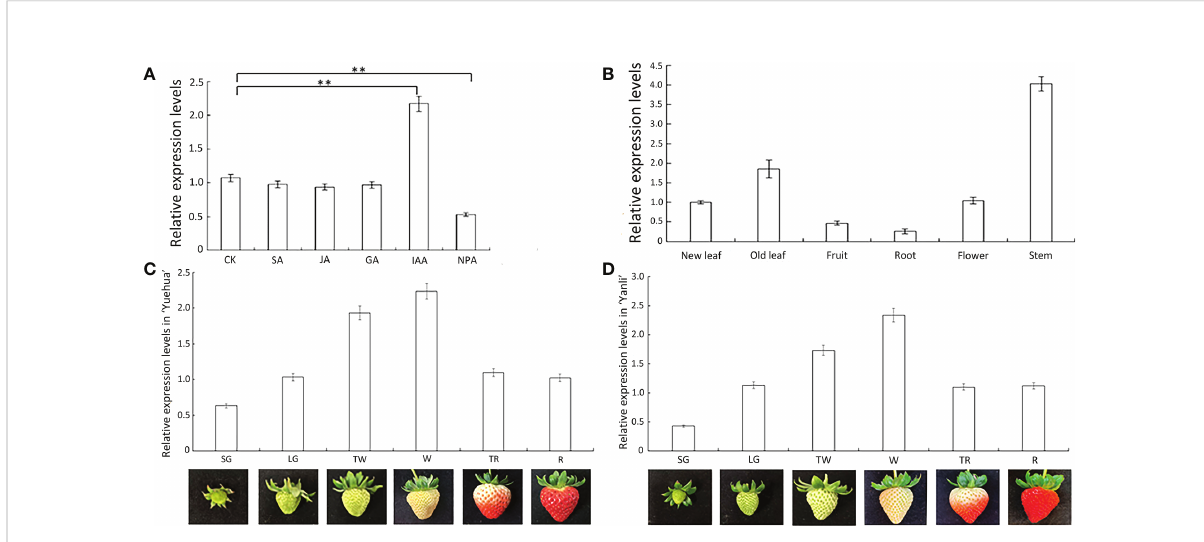
FIGURE 2 Relative expression characteristics of FveARF2. (A) Expression levels of FveARF2 after different hormone treatments. (B) Expression levels of FveARF2 in different organs of the ‘ Ruegen ’ cultivar. (C, D) Expression levels of FveARF2 at different developmental stages of strawberry cultivars ‘ Yuehua ’ and ‘ Yanli ’ fruit. Values are the mean ± SD from three independent experiments with three biological replicates. ‘ ** ’ Indicates very signi fi cantly different (P < 0.01, Duncan ’ s multiple range